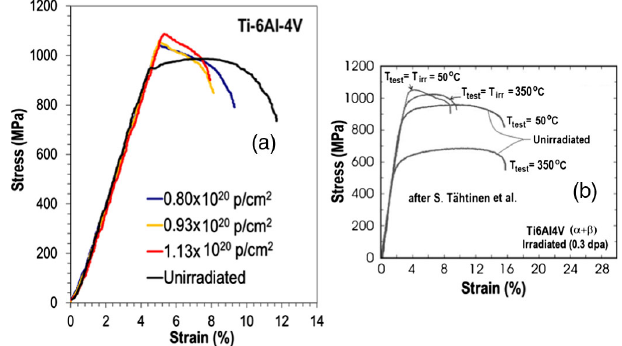
FIG. 21. (a) Proton irradiation dose ( ∼ 0 . 25 dpa maximum) on Ti-6Al-4V stress-strain behavior compared to (b) neutron effects on stress strain [22].